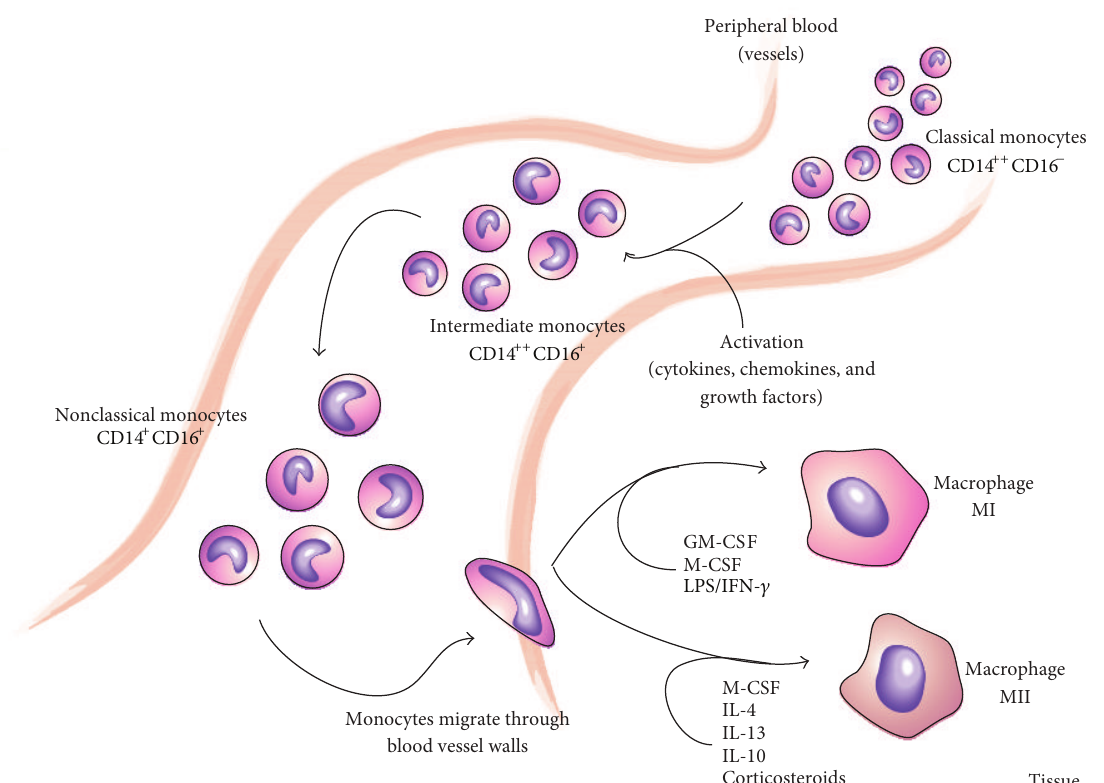
Figure 1: Differentiation of monocytes towards